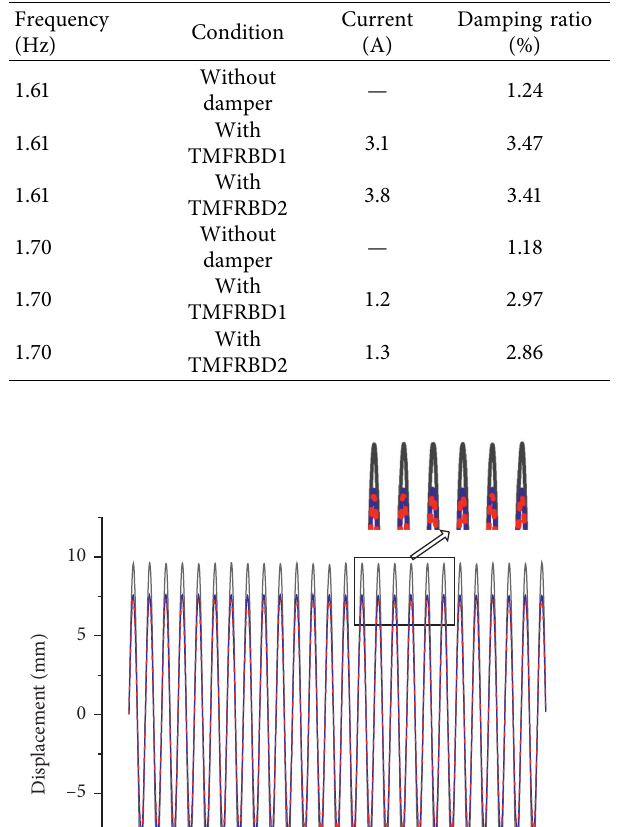
Table 1: The test results of free attenuation vibration.